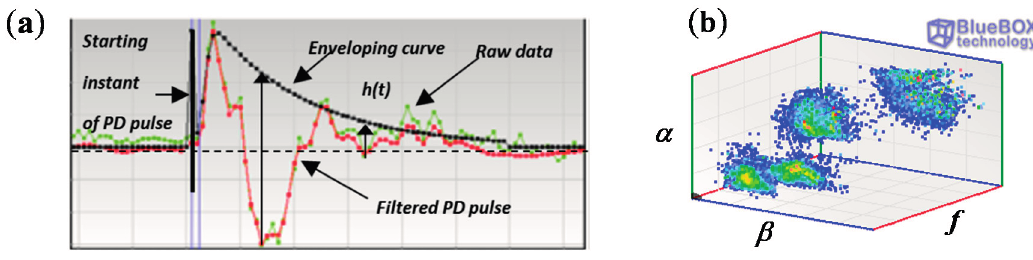
Figure 15. ( a ) Enveloping function for a filtered PD pulse; ( b ) 3D diagram for the classification of pulse sources by